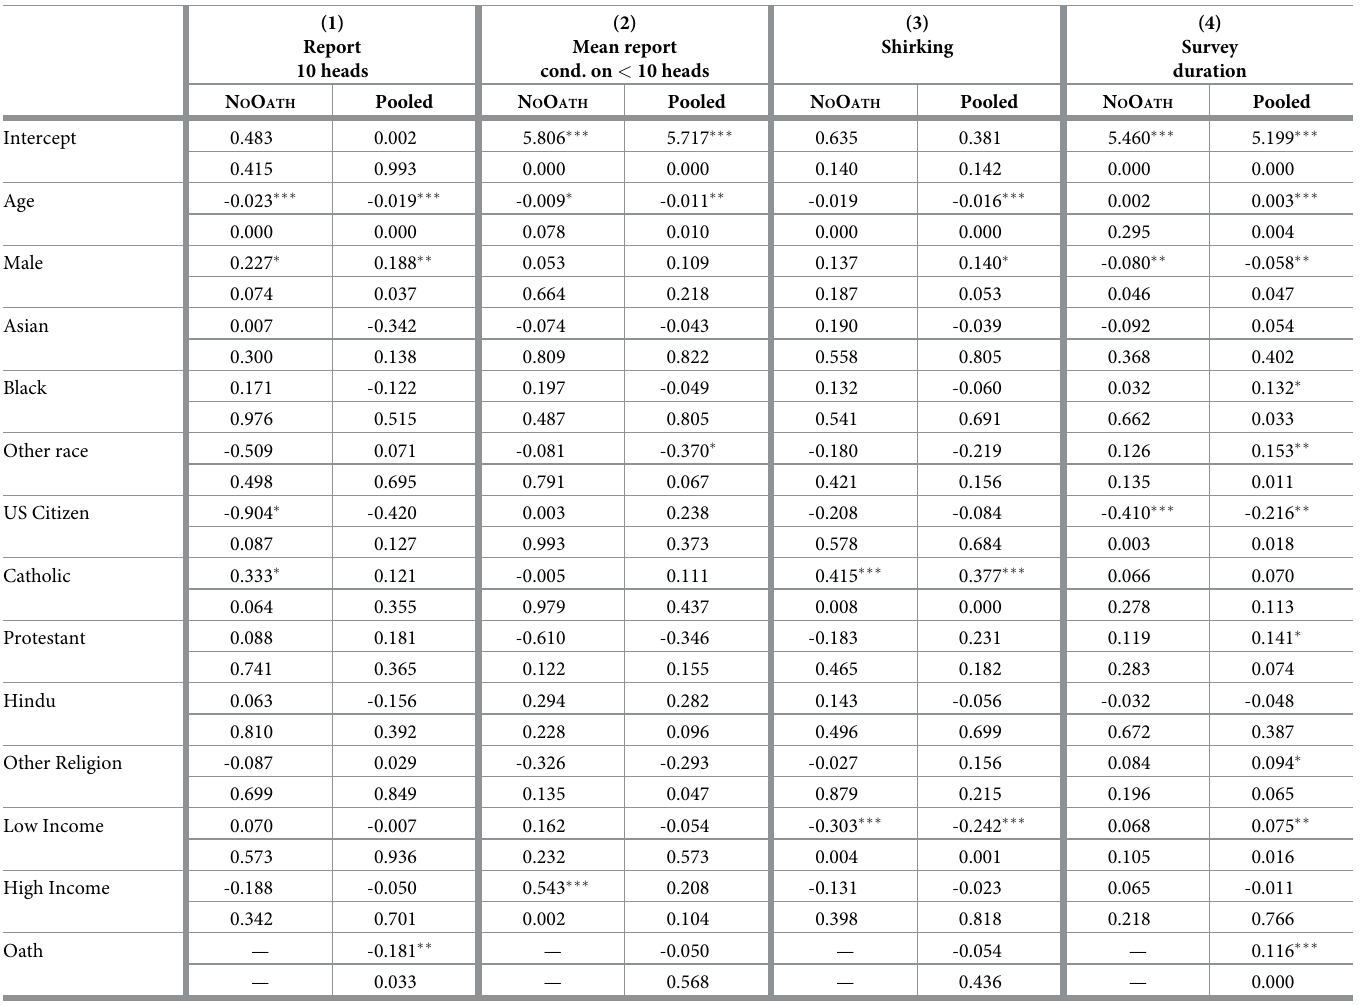
Table 3. Conditional estimates of the effect of the